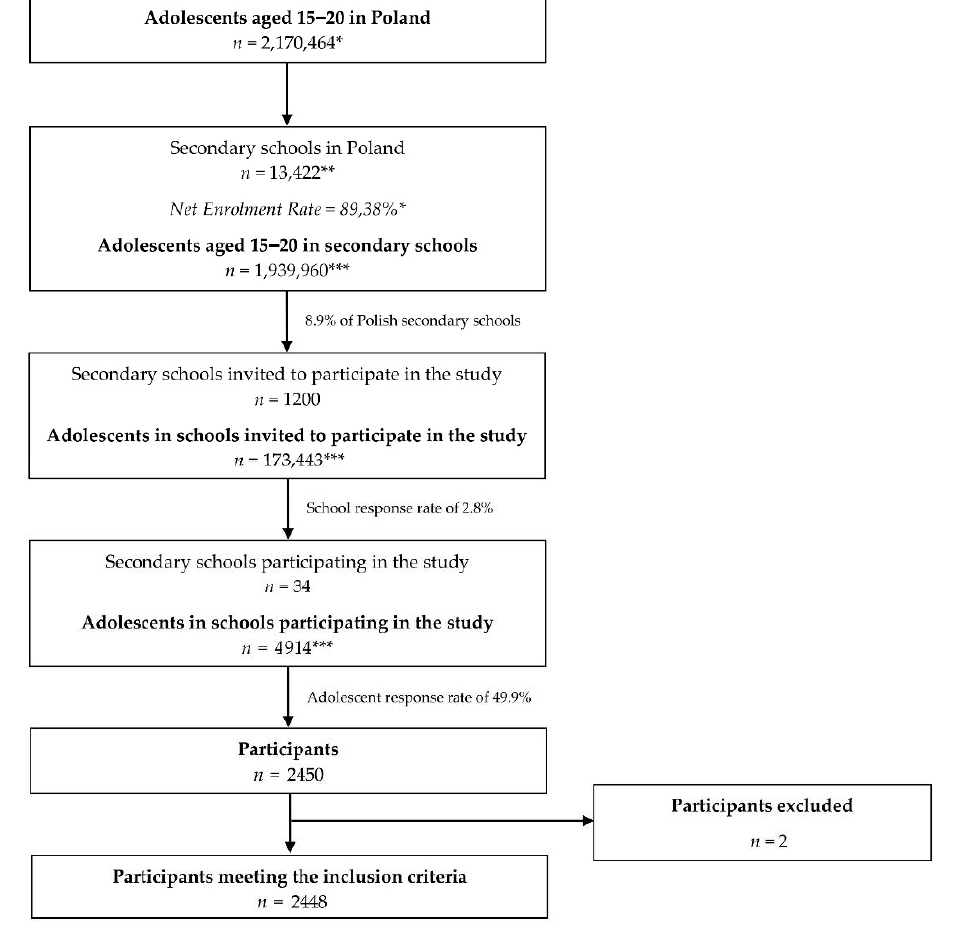
Figure 1. The flow chart of the school sampling and participants included. * by Statistics Poland [28,29]; ** by the Polish Ministry of National Education [30]; *** calculated on the basis of the data by Statistics Poland.